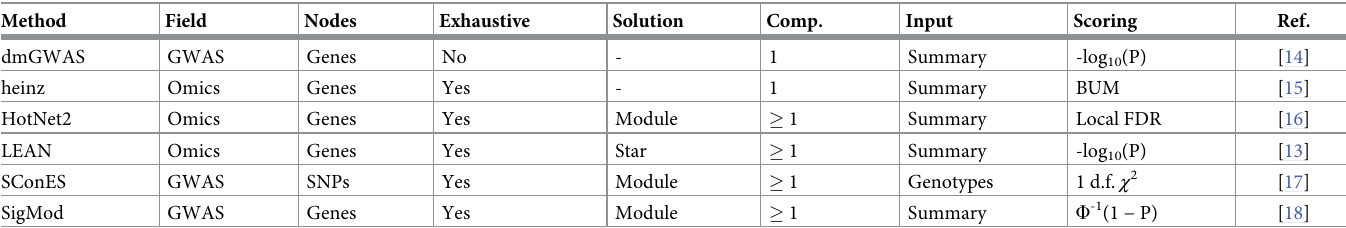
Table 1. Summary of the differences between the network